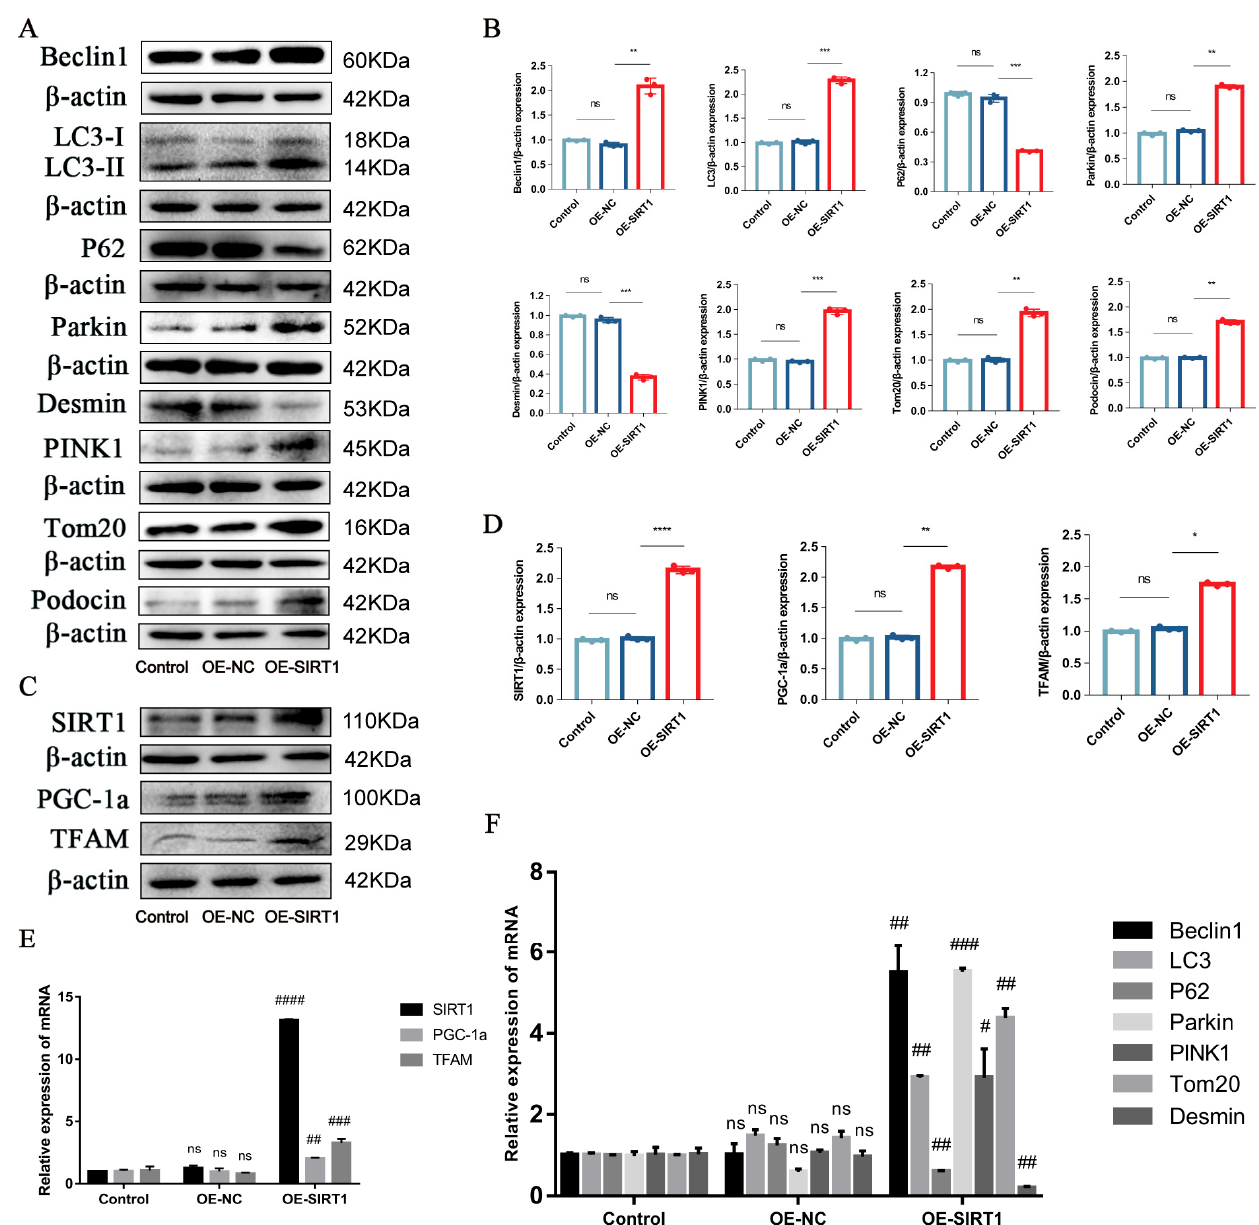
Figure 6. SIRT1 overexpression alleviated podocyte injury and PINK1/Parkin-mediated mitophagy inhibition. ( A , B ) Representative Western blot analysis of Beclin1, LC3II/LC3I ratio, P62, Parkin, PINK1, and Tom20, as well as Podocin and Desmin in MPC5. ( C , D ) Representative Western blot analysis of SIRT1, PGC-1a, and TFAM in MPC5. ( E ) Representative RT-PCR analysis of SIRT1, PGC-1a, and TFAM in MPC5. ( F ) Representative RT-PCR analysis of Beclin1, LC3II/LC3I ratio, P62, Parkin, PINK1, and Tom20, as well as Desmin in MPC5. n = 3 for ( A – F ). β -actin was used as loading control. * p < 0.05, ** p < 0.01, *** p < 0.001 and **** p < 0.0001 vs. the negative control vector (OE-NC). # p < 0.05, ## p < 0.01, ### p < 0.001, and #### p < 0.0001 vs. OE-NC; ns = not